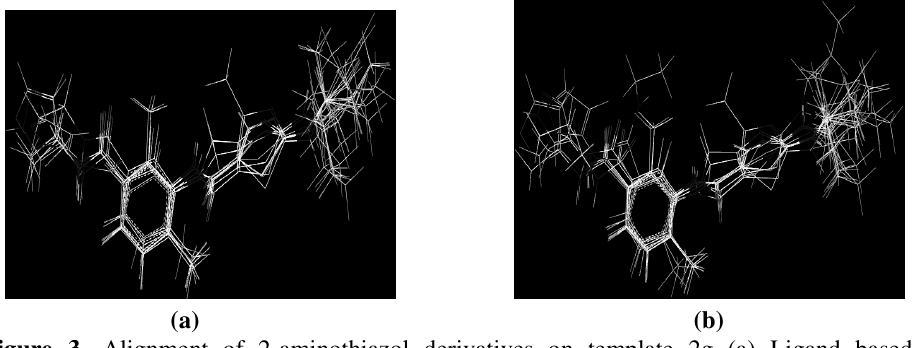
Figure 3. Alignment of 2-aminothiazol derivatives on template 2g (a) Ligand based (b) Receptor (Dock pose) based